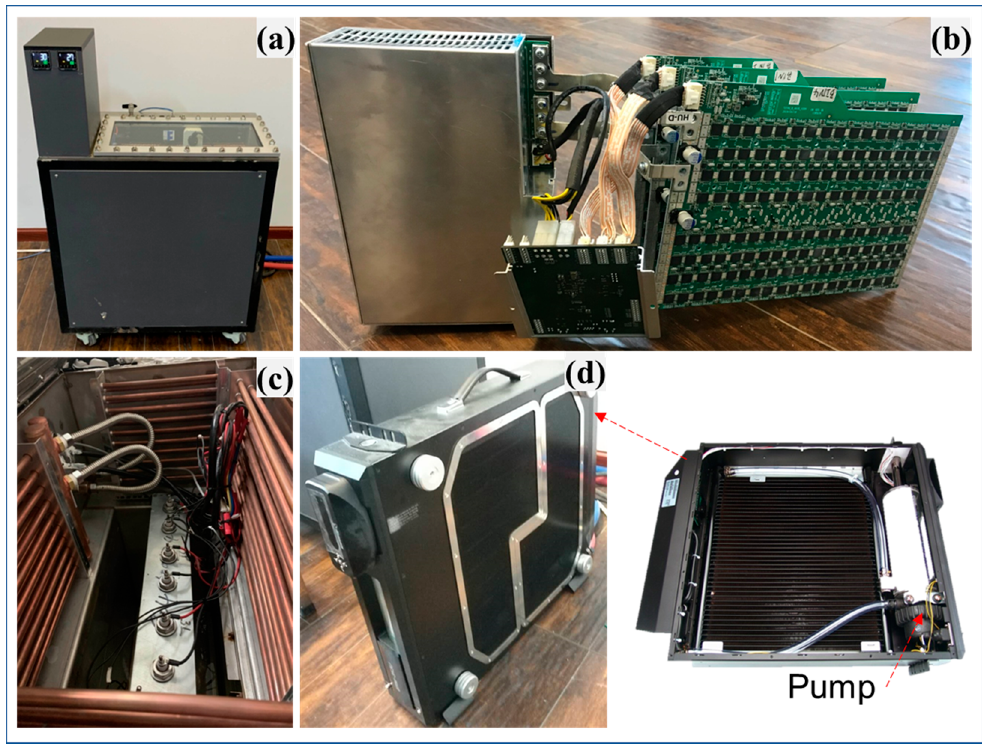
Figure 2. Two-phase cooling tank: ( a ) the tank, ( b ) servers, ( c ) condenser coil, and ( d ) primary heat exchanger. Table 1. Properties of Novec 7100 at 25 ◦ C. Boiling Point ( ◦